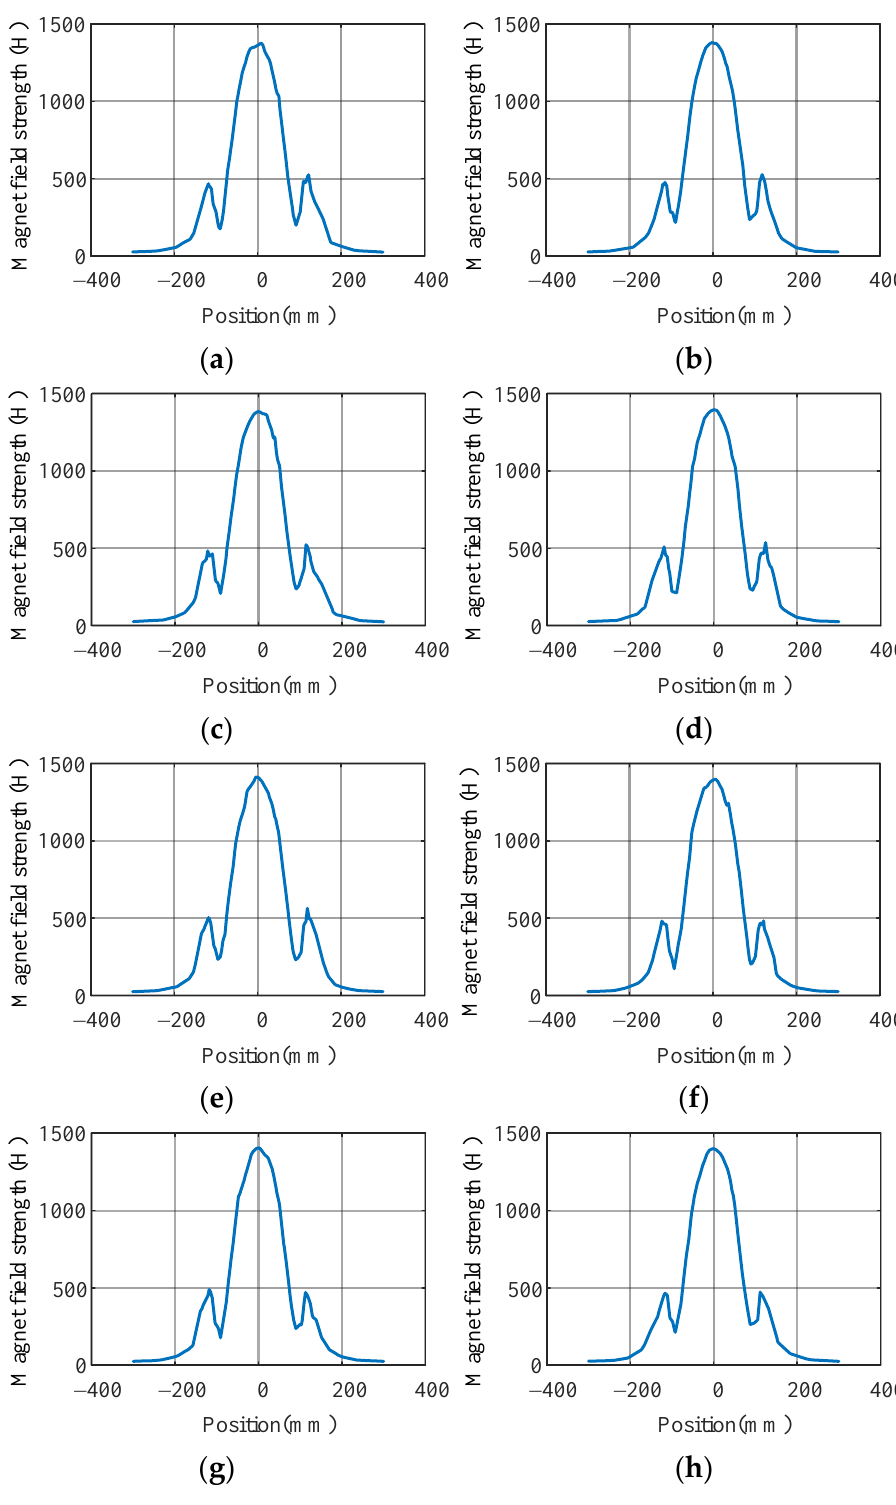
Figure A2. Magnetic field strength curves with different depths. ( a ) 0.5 mm. ( b ) 1.0 mm. ( c ) 1.5 mm. ( d ) 2.0 mm. ( e ) 2.5 mm. ( f ) 3.0 mm. ( g ) 3.5 mm. ( h ) 4.0 mm.